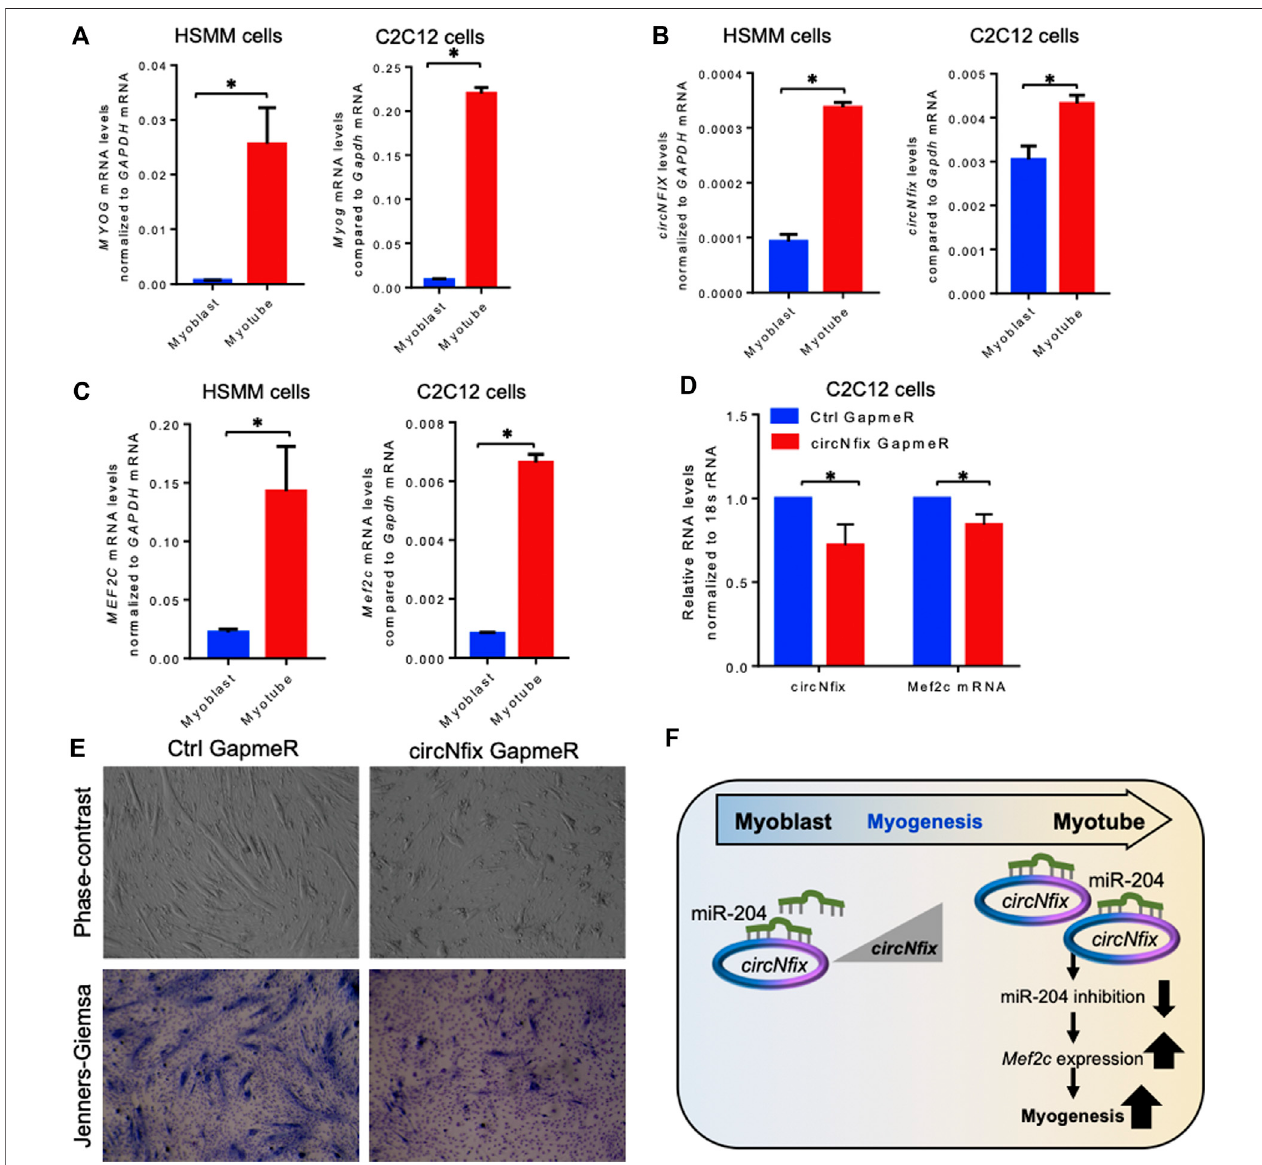
FIGURE4| ExpressionanalysisofcircNFIXanddownstreamtargets. (A) .Relativeexpressionof MYOG mRNAsinproliferatingand4-daydifferentiatedmyotubesofHSMM andC2C12cells. (B) .Expressionlevelsof circNFIX measuredbyRT-qPCRanalysisinproliferatingmyoblastsand4-daydifferentiatedmyotubesofHSMMandC2C12cells. (C) . RT-qPCRanalysisof MEF2C mRNAlevelsinproliferatingmyoblastsand4-daydifferentiatedmyotubesofHSMMandC2C12cells. (D) .RT-qPCRanalysisofcircN fi xandMef2c expression levels in 4 day differentiated C2C12 cells transfected with Ctrl and circN fi x GapmeR 24 hours before starting differentiation. (E) . The phase-contrast fi elds and Jenners-Giemsastained 4-day differentiated C2C12cellstransfected with Ctrland circN fi x GapmeR 24 hours before startingdifferentiation. (F) . Proposed hypothesis of circN fi x action during myoblast differentiation. Data in (A,B,C,D) are the means ± SEM from three independent experiments. *, p < 0.05.